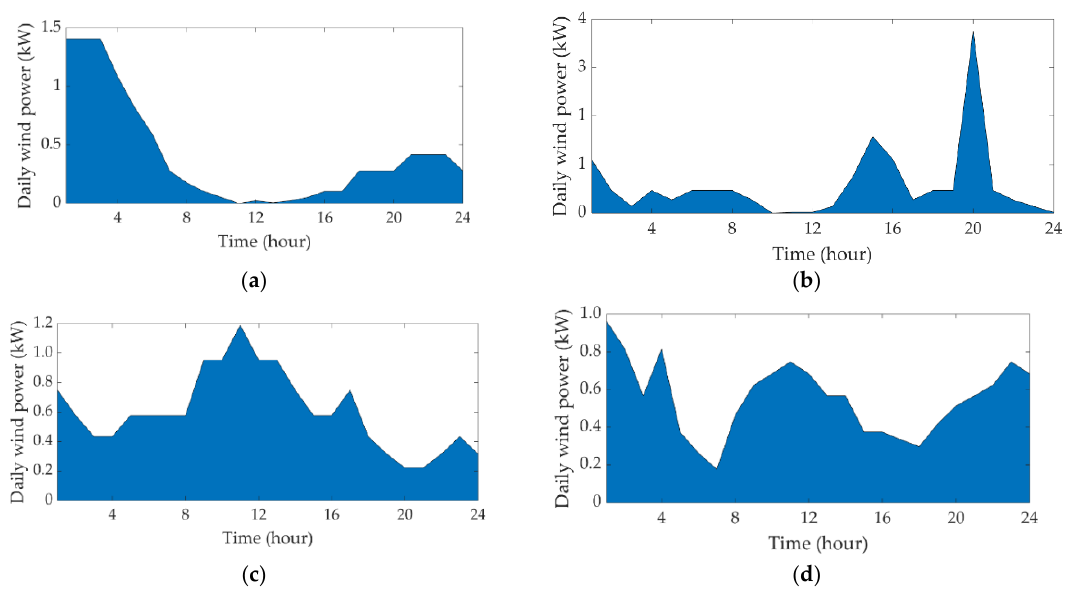
Figure 9. Annual wind speed on site.